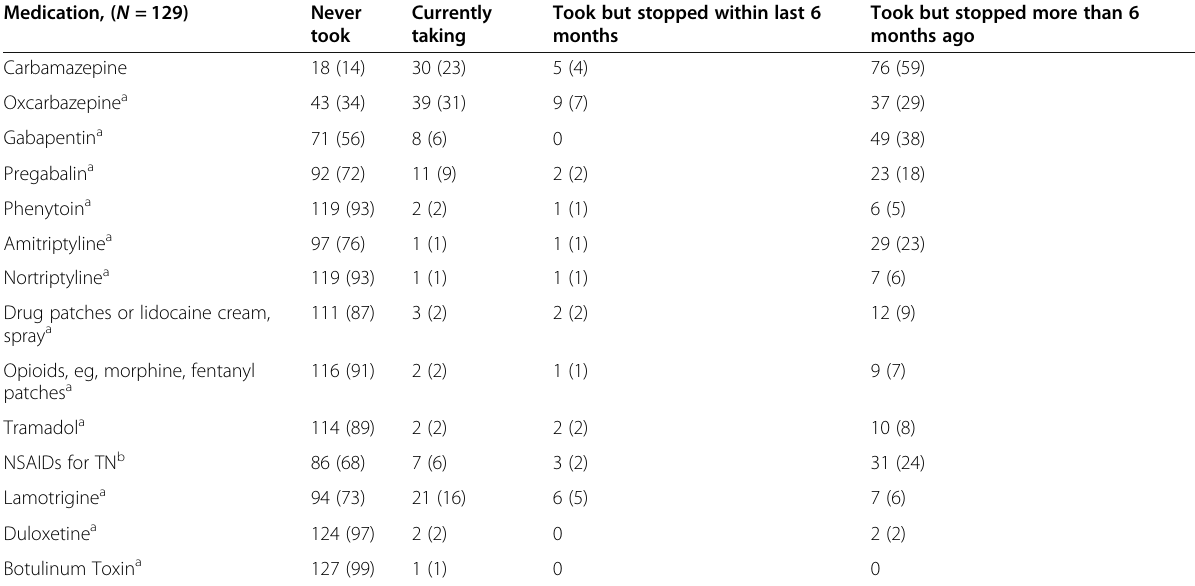
Table 3 History of Specific Medication Use for TN, n (%) Medication, ( N = 129) Never